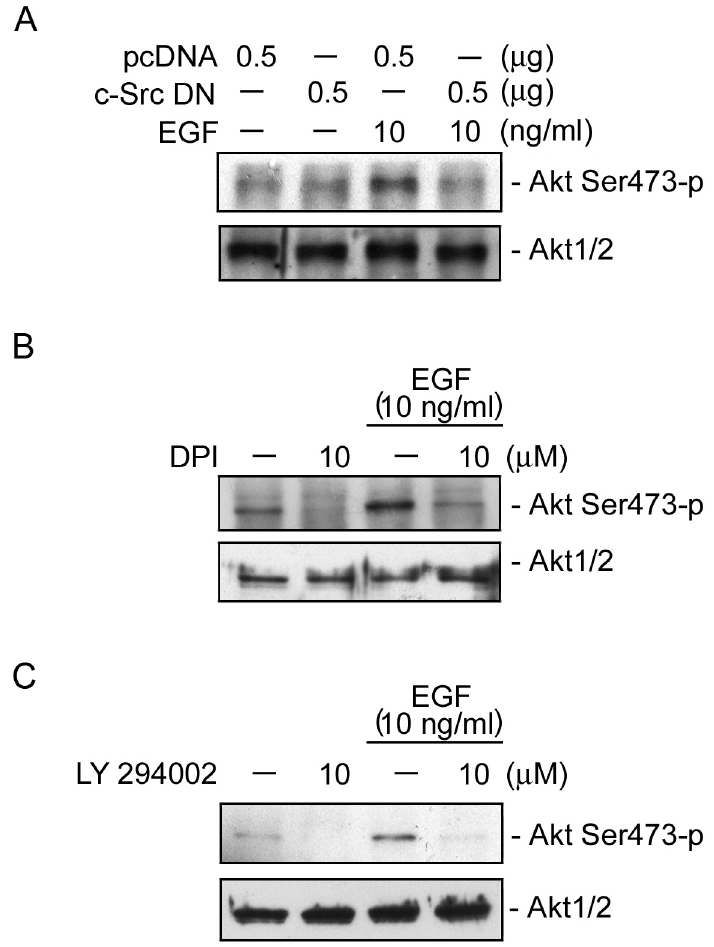
Figure 6. Involvement of c-Src, NADPH oxidase, and PI3K in epidermal growth factor (EGF)-induced Akt Ser473 phosphorylation in HT-29 cells. HT-29 cells were transiently transfected with 0.5 m g of pcDNA or 0.5 m g of a dominant negative mutant of c-Src (c-Src DN) (A) for 24 h, or cells were pretreated for 30 min with 10 m M DPI (B) or 10 m M LY 294002 (C) and then stimulated with 10 ng/ml EGF. After 20 min of stimulation, Akt Ser473 phosphorylation was determined. Immunoblots are representative of three experiments with similar